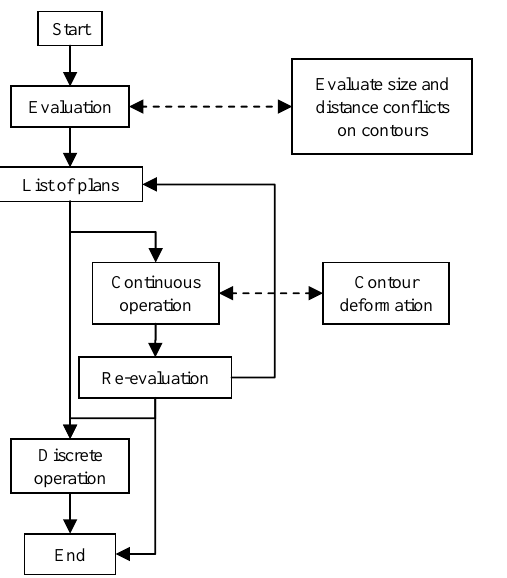
Figure 6: Flowchart of the feature generalisation process.